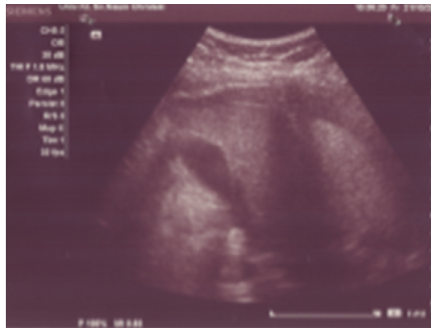
Figure 2: Abdominal ultrasound shows ascites without findings of liver cirrhosis or portal hypertension.